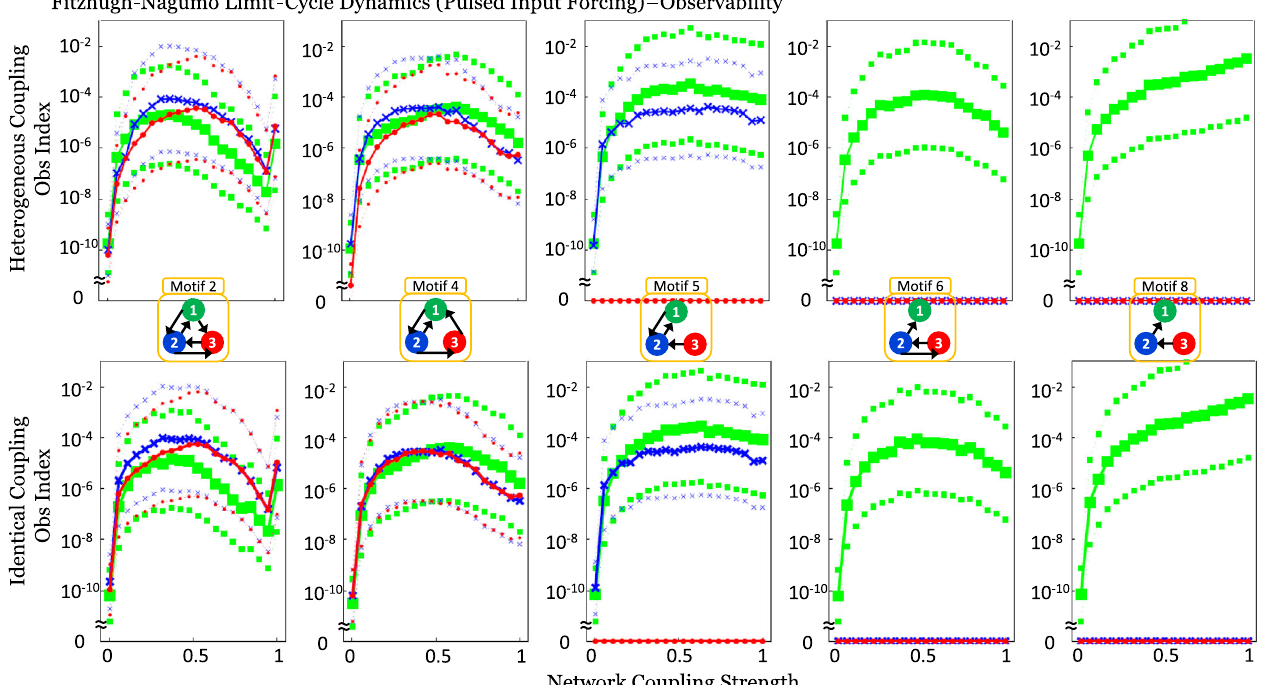
FIG. 5. Calculation of observability indices for each of the FN network motifs with no underlying group symmetries for a pulsed input limit-cycle dynamical regime, as measured from each node (green squares, 1; blue crosses, 2; red dots, 3). The thick lines and symbols mark the mean values while the smaller symbols and dotted lines represent the (cid:4) 1 standard deviation confidence intervals. Plots in the top row are computed with heterogeneous couplings while identical coupling strengths are in the bottom row. The calculations show the effect of network coupling strength on observability; motifs 5, 6, and 8 show no observability from node 3 in motif 5, and from nodes 2 and 3 in motifs 6 and 8 due to structural